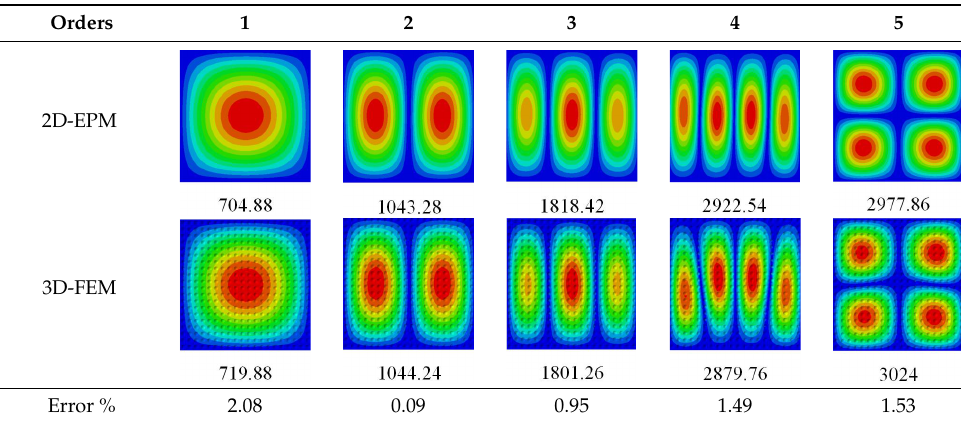
Table 2. Comparison of the first five buckling mode of CCCP in Case 3 predicted by different models (unit: N).